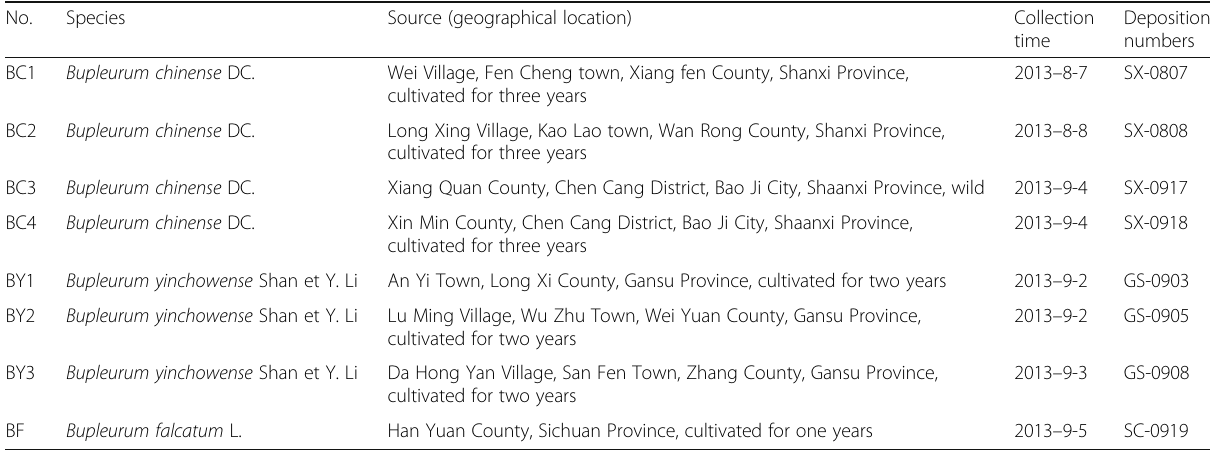
Table 1 Sample information for the analysis